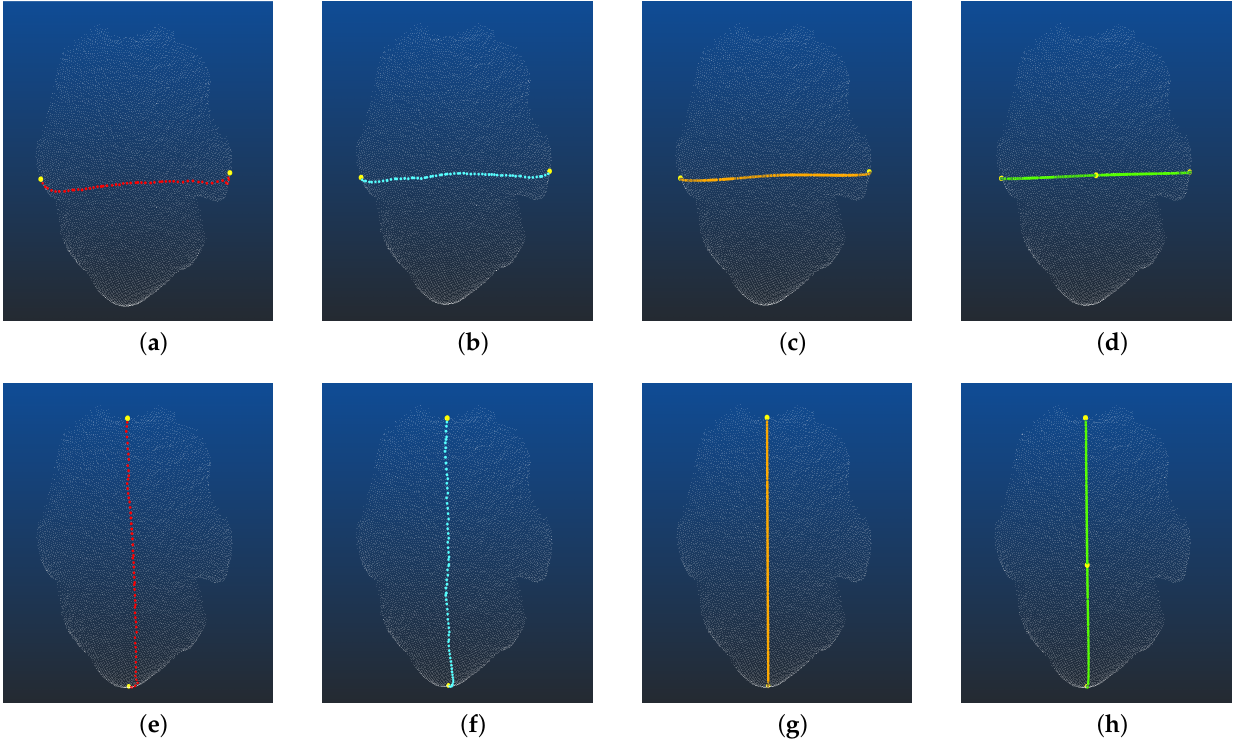
Figure 6. Obtaining the point sets of leaf length and width. ( a ) Obtaining the key point set of width by A* algorithm. ( b ) Obtaining the key point set of width by Dijkstra algorithm. ( c ) Obtaining the key point set of width by cross-section algorithm. ( d ) Obtaining the key point set of width by our method. ( e ) Obtaining the key point set of length by A* algorithm. ( f ) Obtaining the key point set of length by Dijkstra algorithm. ( g ) Obtaining the key point set of length by cross-section algorithm. ( h ) Obtaining the key point set of length by our